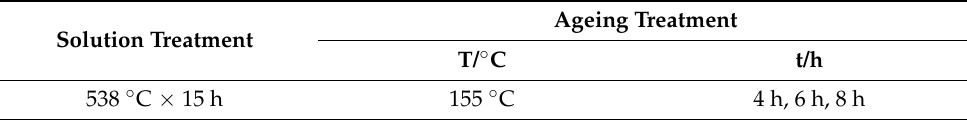
Table 2. Ageing treatment process of specimens.